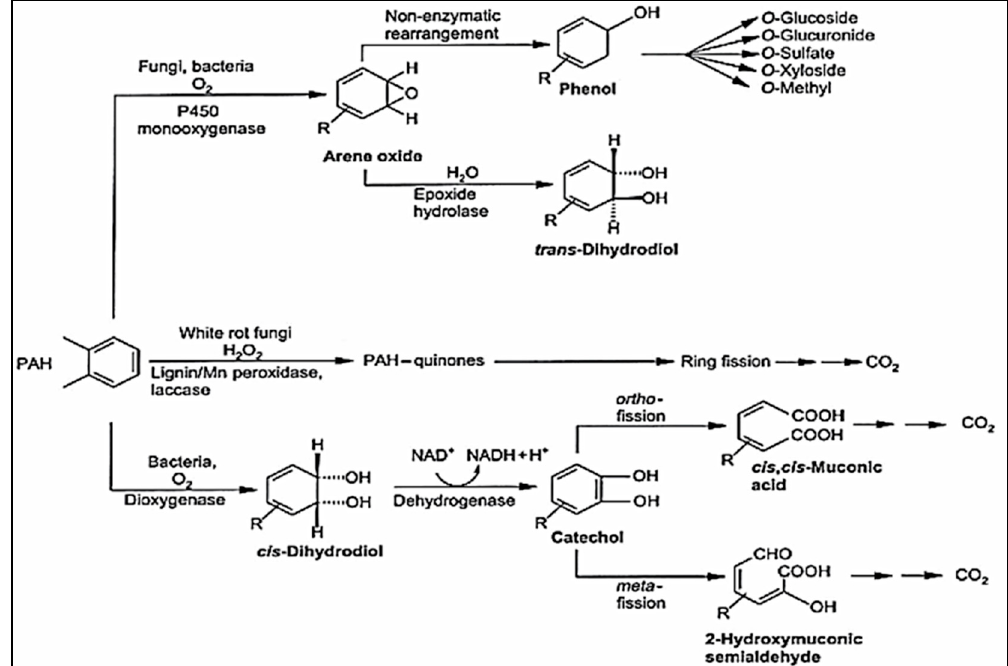
Figure 3. Pathway for the biochemical and microbial genetic pathway. Adapted from Hidayat and Turjaman [11].